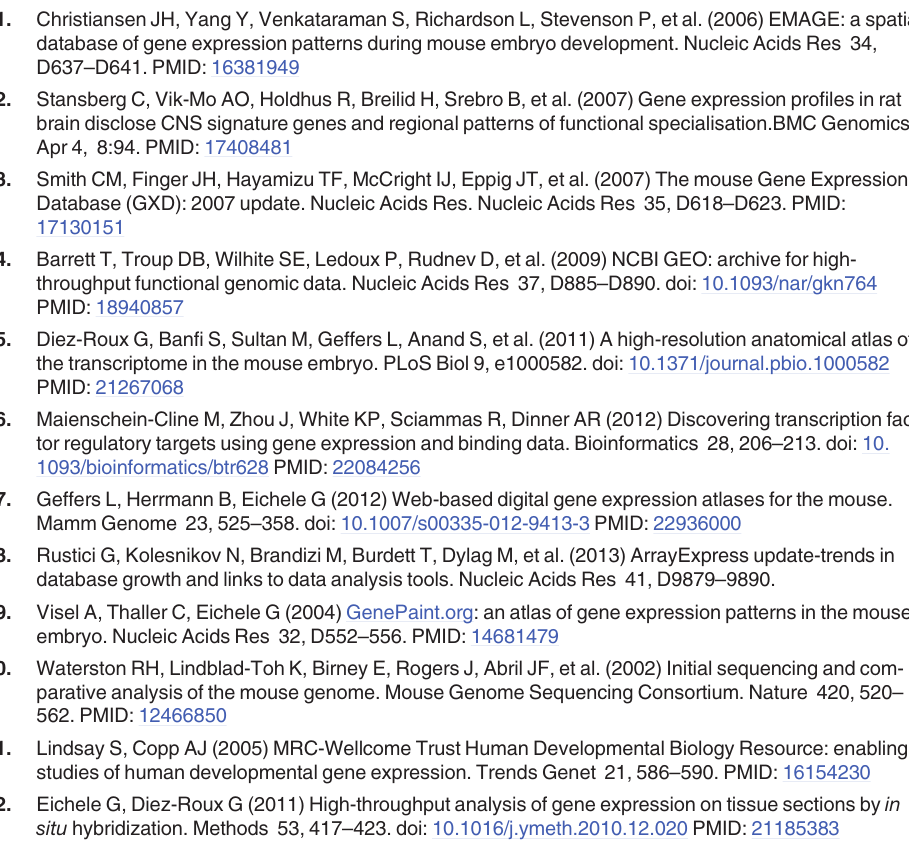
Percentages are relative to the 2000 annotated genes. Gray lines indicate genes expressed in one specific tissue and absent in the four other tissues. The lines “ w+m+s ” give the total numbers of genes exhibiting weak, medium or strong expression in each organ. S2 Table. List of the 623 genes co-expressed in KUROV organs. S3 Table. List of the 74 KUROV genes related to diseases according to the Morbid Map da-